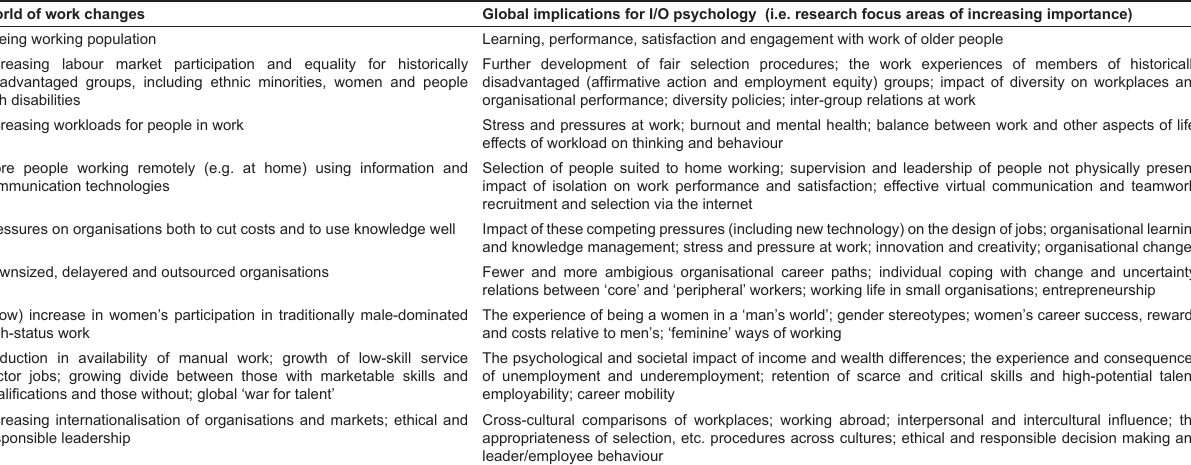
TABLE 1 World of work changes and their global implications for Industrial and organisational